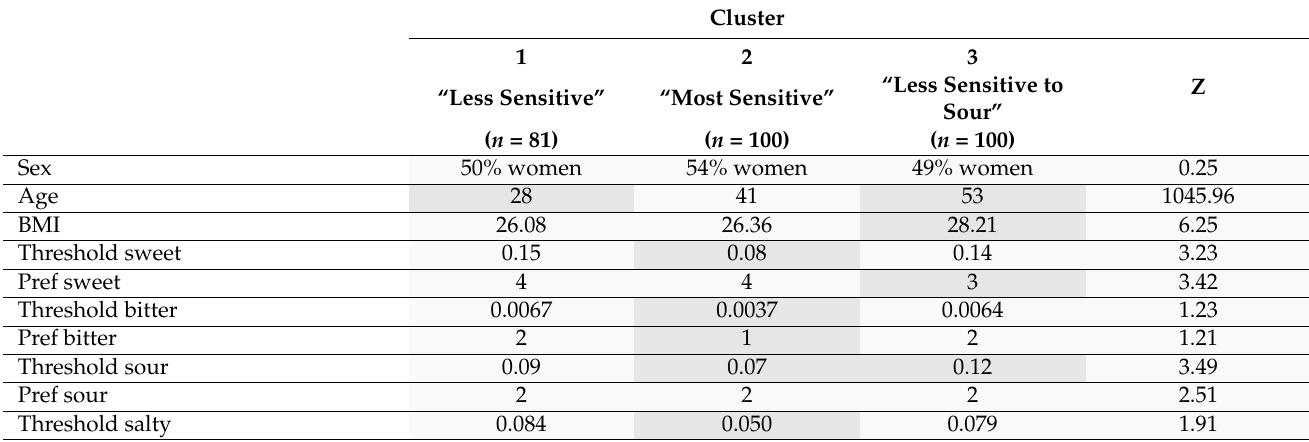
Table 5. Final cluster centers (means) of the taste and nutritional variables (important differences which identify the clusters are shown in light gray